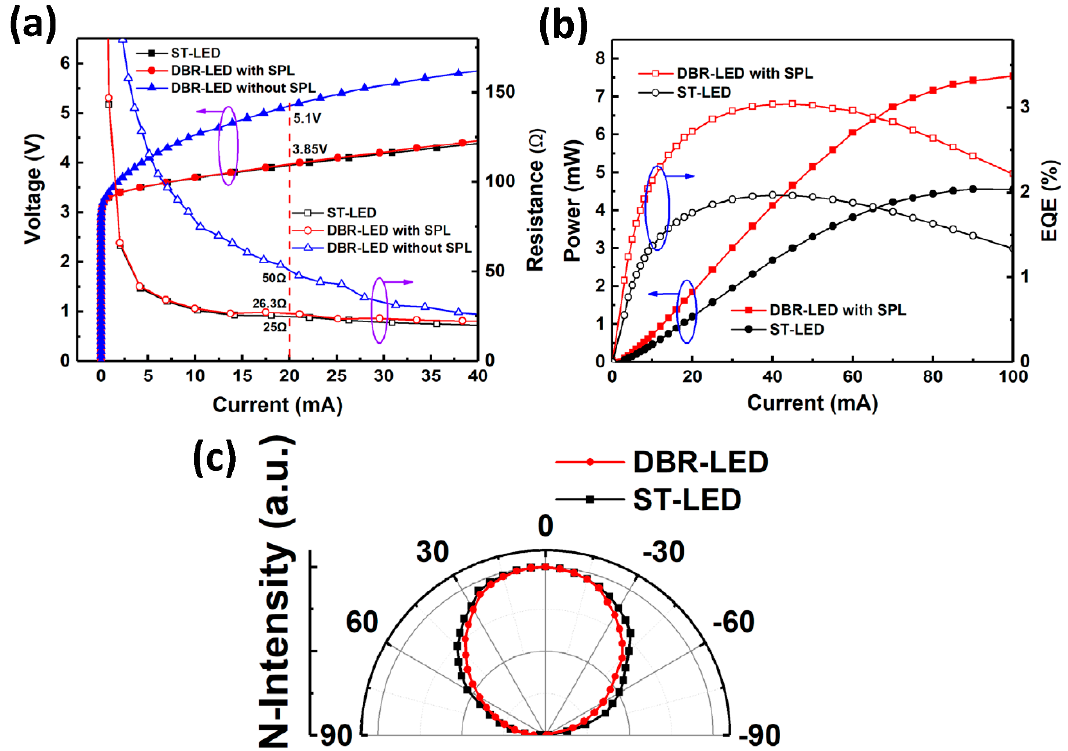
Figure 9. ( a ) I-V characteristics of UV LEDs; ( b ) P-I characteristics of UV LEDs; ( c ) normalized far-field distributions of UV LEDs.